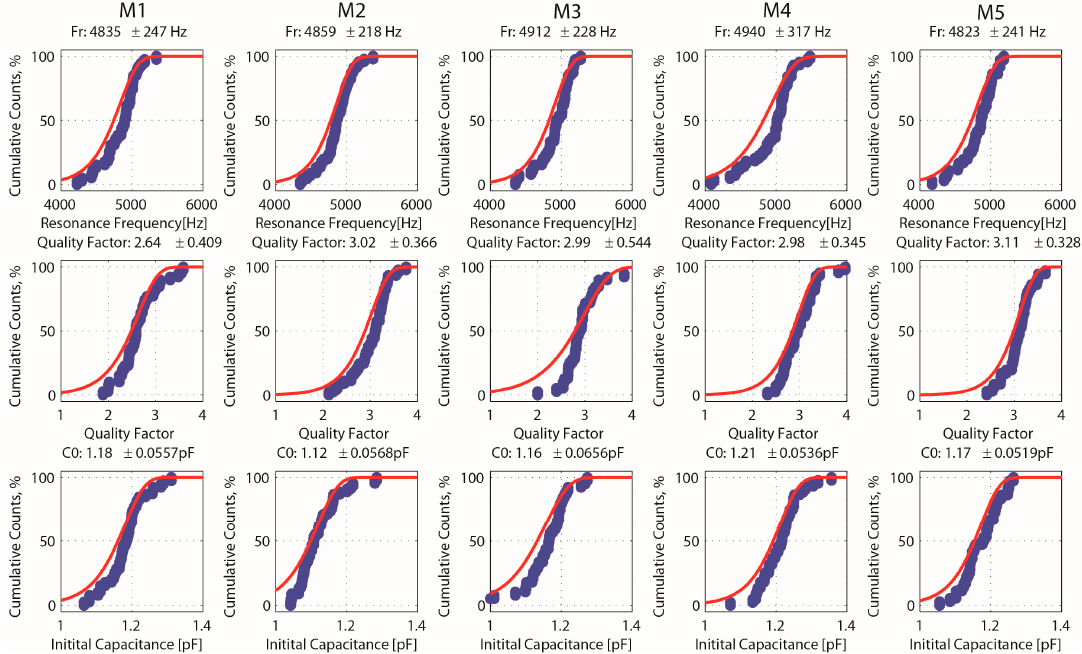
Figure 16. Cumulative distribution curves for resonance frequency, quality factor, and initial capacitance for the five different layouts (M1–M5). Table 2. Expected parameters of devices M1–M5 based on layout, assuming 1 µ m over-etch.